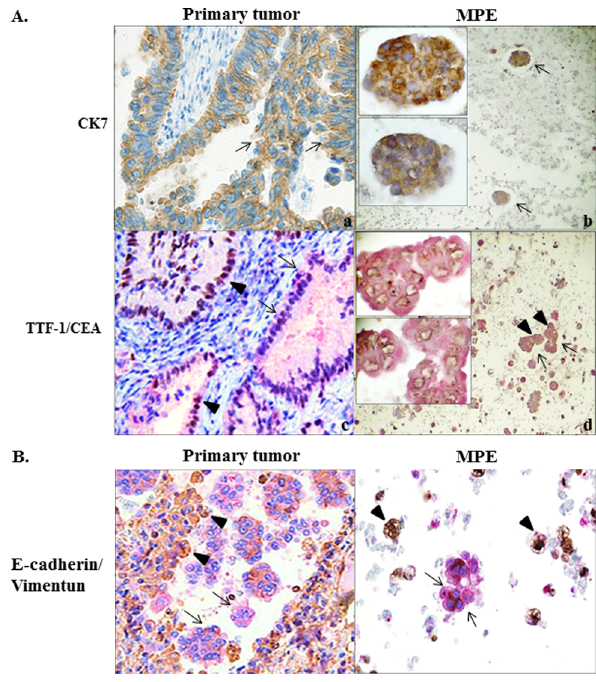
Figure 1. Confirmation and identification of adenocarcinoma in the lung and pleural effusions with subsequent coexpres- sions of EMT-associated markers. (A) Immunohistochemical identification of adenocarcinoma cells showed positive results of CK-7 (arrows) in both primary pulmonary tumor (Magnification, 200 6 ) and cell nests in cell block of MPE at lower and higher magnifications (a, b) (Magnification, 40 6 and 400 6 ); Double-staining of TTF-1/CEA revealed that TTF-1 (brown color, arrow heads) and CEA (red color, arrows) were evenly positive-stained in primary pulmonary tumor (c) (Magnification, 200 6 ), while CEA ( + ) cells (arrows) are stained stronger than those of TTF-1 ( + ) cells (arrow heads) in cell block of MPE at lower and higher magnifications (d). (Magnification, 40 6 and 400 6 ). (B) Double-staining of E-cadherin/vimentin showed that decreased E-cadherin (brown color, arrows) and increased vimentin (red color, arrow heads) expressions were found at the invasive fronts of primary pulmonary tumor and in cell block of MPE. (Magnification, 200 6 ) (C).